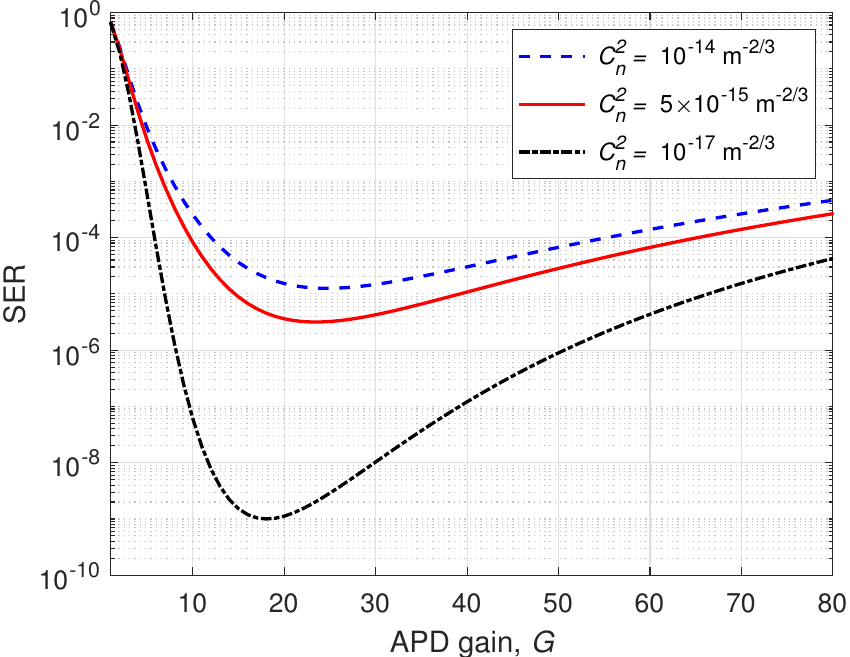
Figure 5. SER versus APD gain, G , for different values of turbulence strength with a transmission link length of 800 m, an average transmitted power per symbol of P t = − 5 dBm.